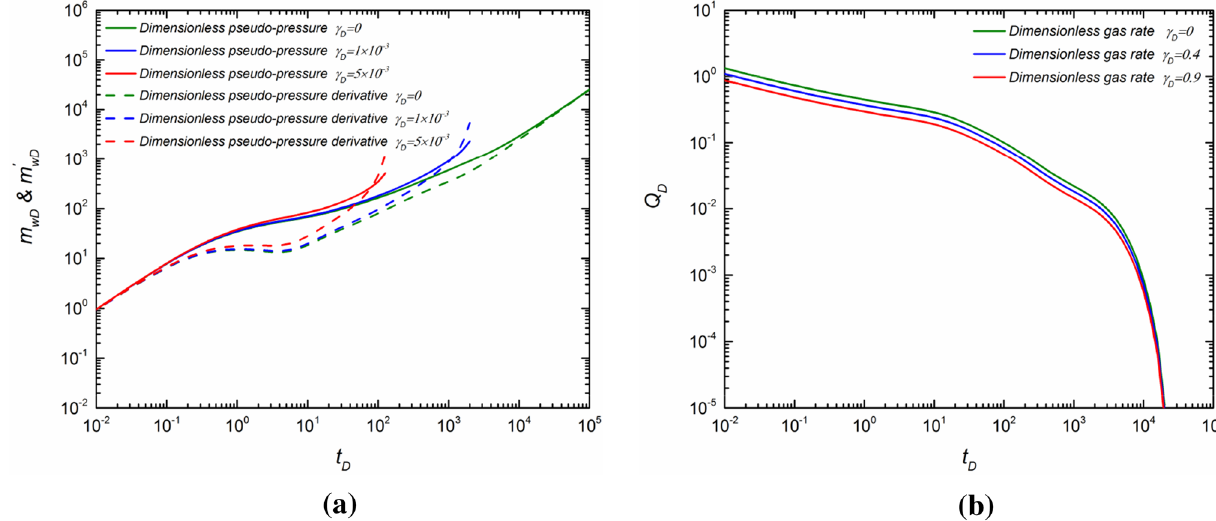
Fig. 11 Effect of dimensionless permeability modulus on pseudo-pressure and rate curves. a Dimensionless pseudo-pressure and pseudo-pres- sure derivative curve, b dimensionless rate